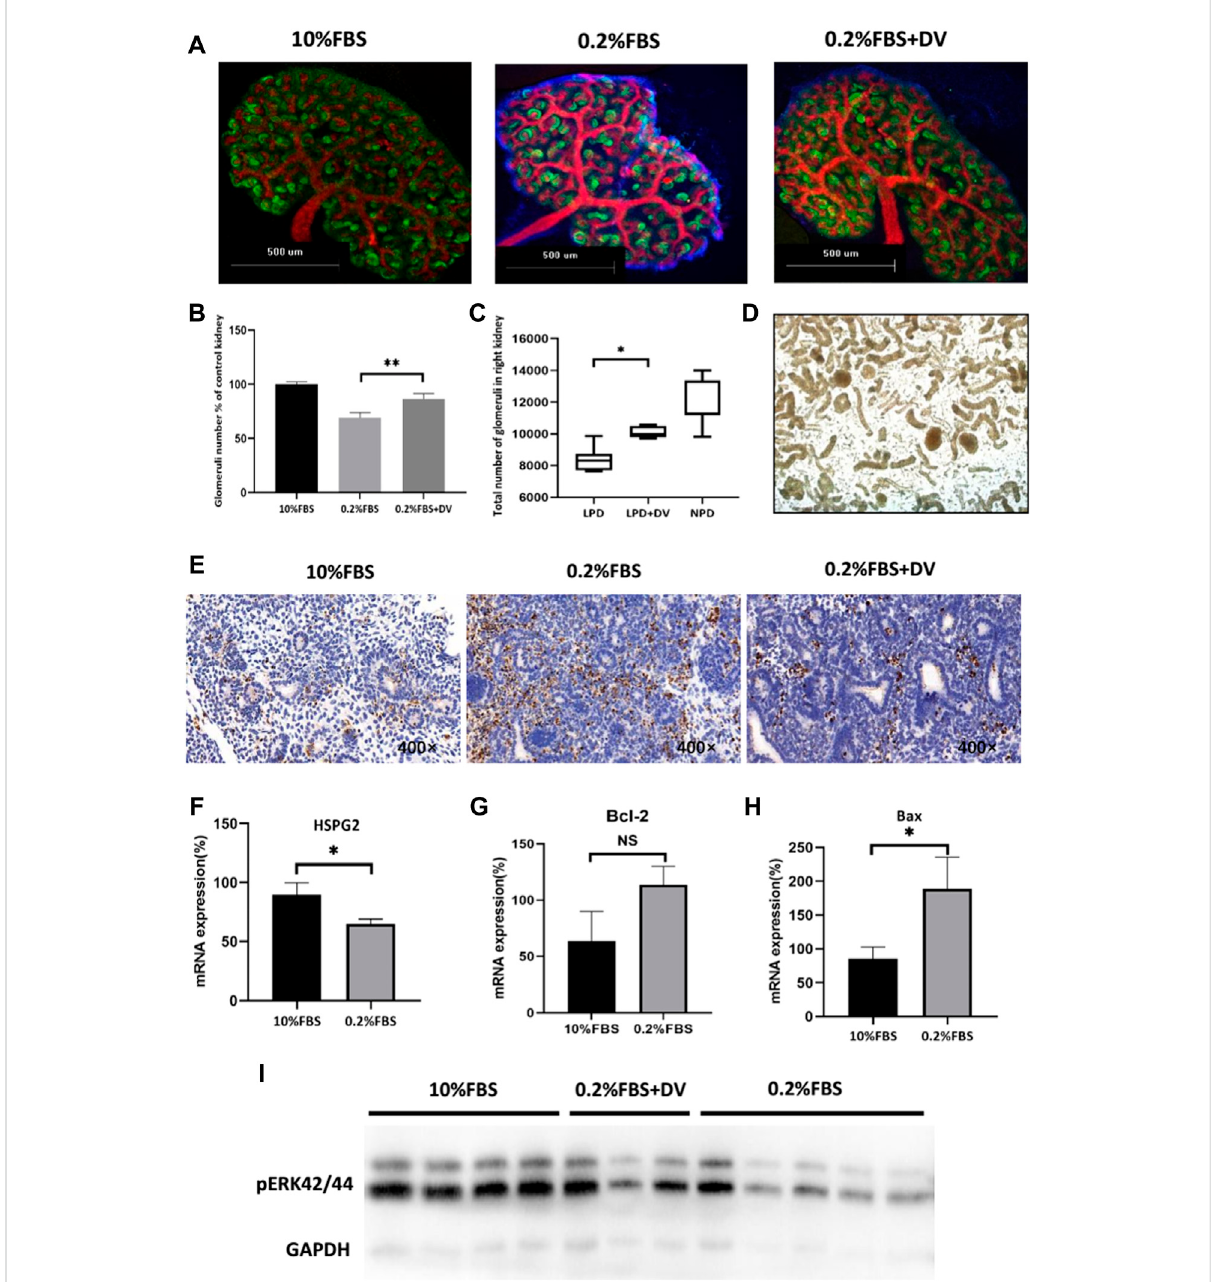
FIGURE 2 Endorepellin rescues the nephron number and reduces apoptosis in renal developmental programming. (A) Representative images of metanephros stained with Wt1 (green) and E-cadherin (red) antibodies to identify newly formed glomeruli and ureteric branches in normal serum conditions (10% FBS), serum deprivation (0.2% FBS), and co-culture with endorepellin (2ug/ml). (B) Serum deprivation in metanephros ( n = 6) decreased the number of glomeruli to 69 + 4.2% of kidneys grown in 10% FBS ( n = 6). Endorepellin signi fi cantly improved the number of glomeruli in serum-deprived metanephros to 86 ± 4.6% ( n = 6). (C) The total number of glomeruli in 4-week-old mice exposed to a normal-protein diet (22%) or a low-protein diet (6%) with or without endorepellin during the fi rst week of life. (D) Representative image of kidney-dissociated tissue under a microscope with hydrochloric acid digestion. Glomeruli are indicated by arrows. (E) Representative immunohistochemistry images of embryonic kidneys labeled with TUNEL (POD) to detect apoptotic cells. (F – H) Expression of Hspg2, Bcl-2, Bax, and mRNA in cultured metanephros exposed to 10% FBS or 0.2% serum deprivation, relative to control ( n = 6). (I) Immunoblotting analysis of phosphorylated ERK1/2 in cultured metanephros exposed for 24 h to 10% FBS ( n = 5), 0.2% FBS ( n = 4), or 0.2% FBS supplemented with endorepellin (2ug/ml, n = 3). FBS, fetal bovine